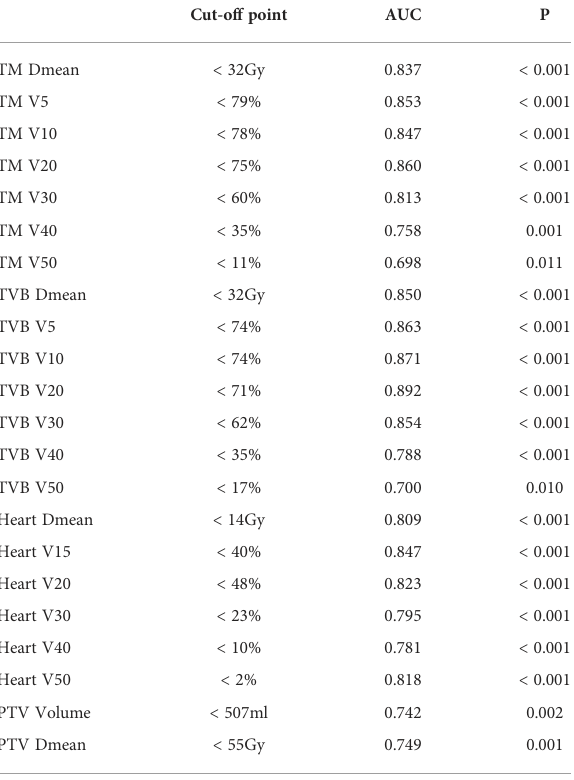
TABLE 4 ROC curve cut-off points for prevention of grade 4 lymphopenia. Cut-off